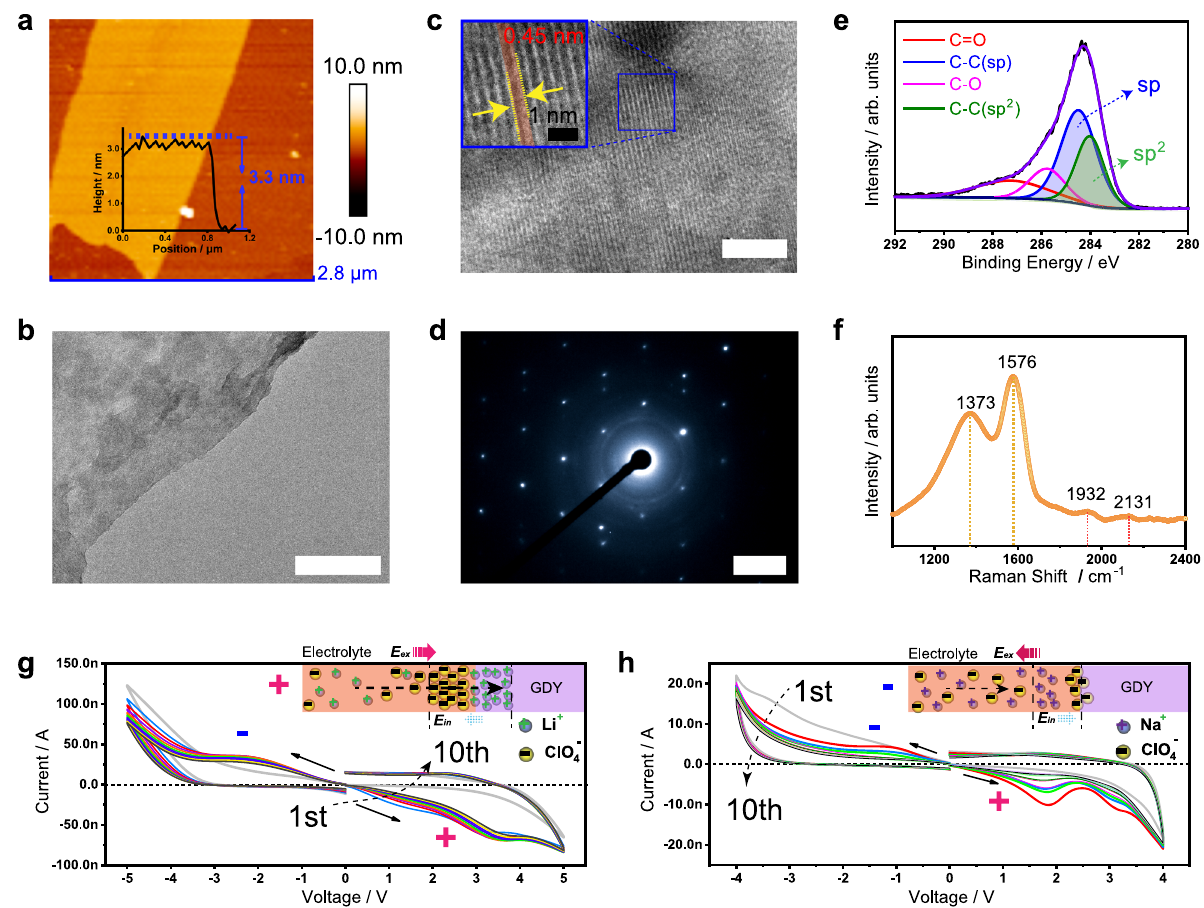
Fig. 2 Characterizations of GDY and GASs. a AFM image, b TEM image (scale bar: 200 nm), c high-resolution TEM image (scale bar: 5 nm), d SAED pattern (scale bar: 5 1/nm), e high-resolution XPS C 1 s spectra, and f Raman spectrum of GDY. g , h I – V curves measured in sweep cycles of 0 to 5 V and 0 to − 5 V for Li-GAS and Na-GAS, respectively. Inset: Schematic illustrations of ion dynamic diffusion under positive and negative